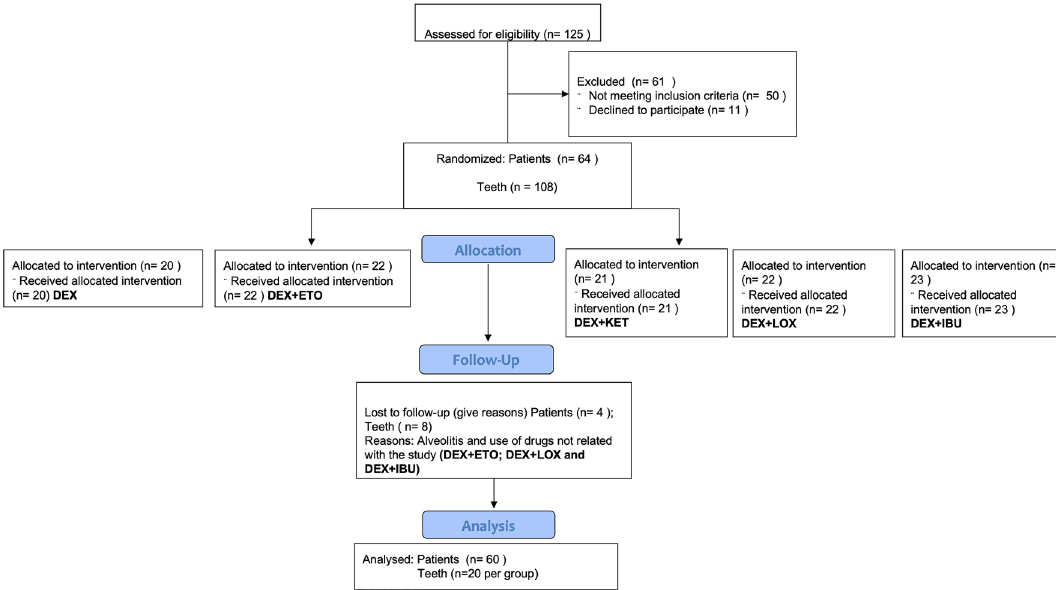
Figure 2. Flowchart of subjects screened according to CONSORT